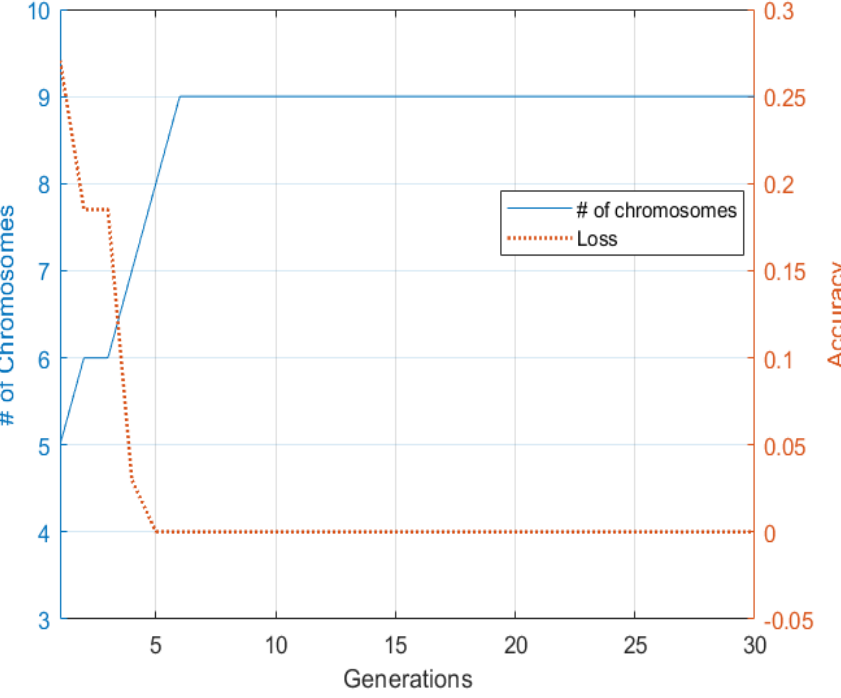
Figure 4. Evolution process of experiment.